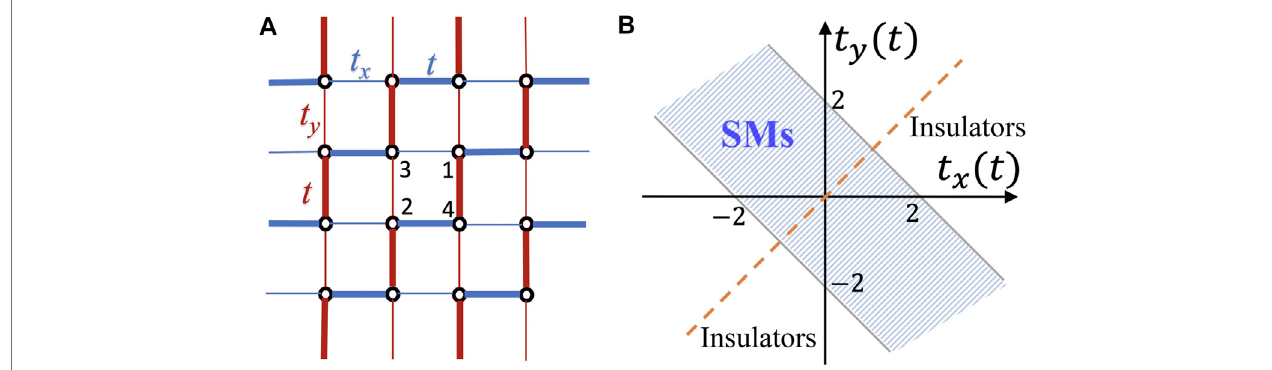
FIGURE 1 | (A) Schematic of the type-I 2D SSH lattice. Blue (red) thick and thin bonds mark alternately dimerized hopping amplitudes in x ( y )-direction. (B) The full phase diagram ofthe type-I 2D SSH model in the parameter space ( t x , t y ).The shadowed region representsthe semimetals (SMs) with apair ofDirac points. Theorange dashed line at t x = t y corresponds to a nodal-line metallic phase. Other regions are the weak topological